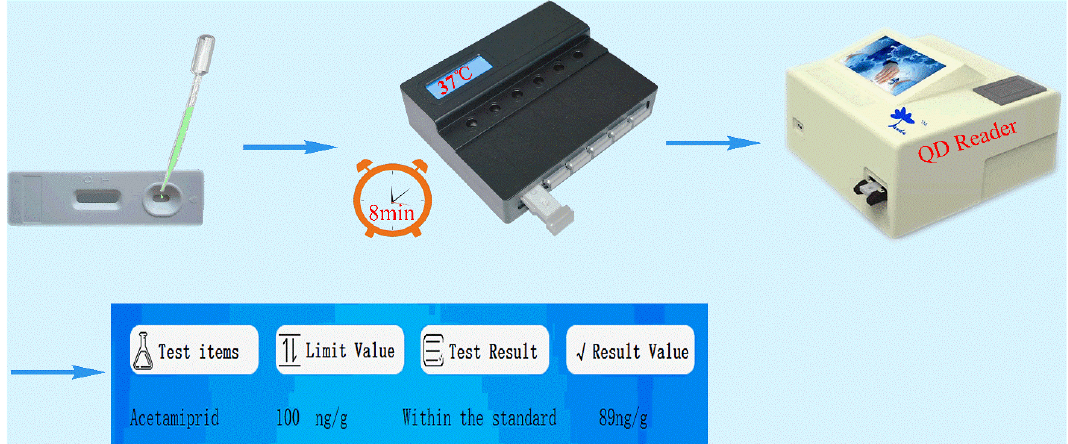
Figure 2. Eight-minute immunochromatographic strip quantification of ACP.